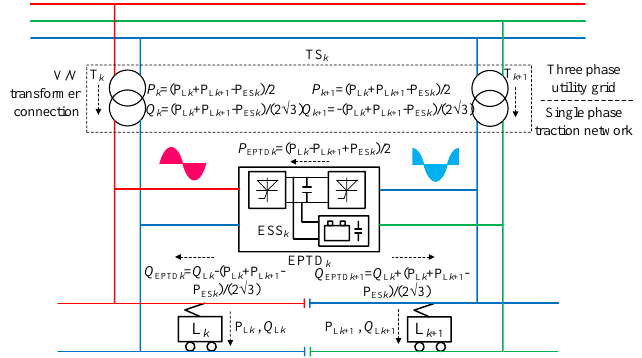
Figure 6. Power quality improvement by PTD with the ESS (EPTD).